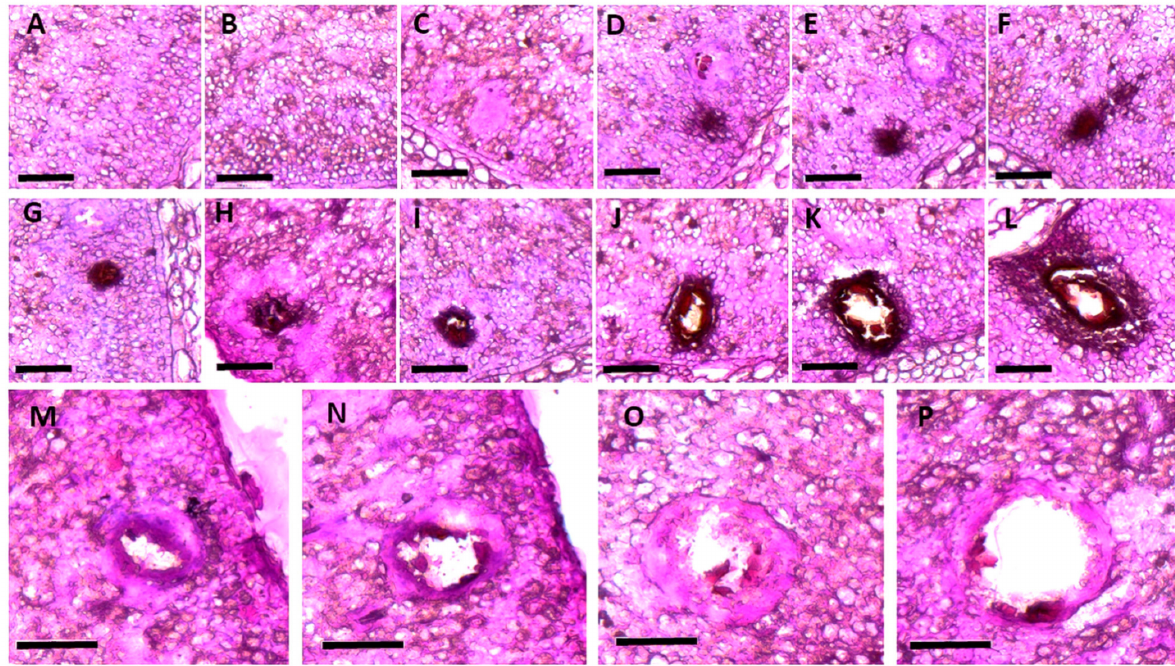
Figure 1. Developmental changes in the morphology of the gossypol gland during embryo formation. Gossypol gland morphology at ( A ) 22 DPA, ( B ) 25 DPA, ( C ) 29 DPA, ( D ) 30 DPA, ( E ) 35 DPA, and ( F ) 50 DPA. ( G ) Cell arrangement at 22 DPA. ( H ) Gossypol gland primordium formation at 25 DPA. ( I ) At 29 DPA, the primordium of the gossypol gland begins to disintegrate. Gossypol gland cavity at ( J ) 29 DPA, ( K ) 35 DPA, and ( L ) 50 DPA. ( M – P ) Gossypol gland formation during seed germination. ( M ) Gossypol gland cavity after 2 h, ( N ) 12 h, ( O ) 36 h, and ( P ) 72 h. Scale bar: 100 µ